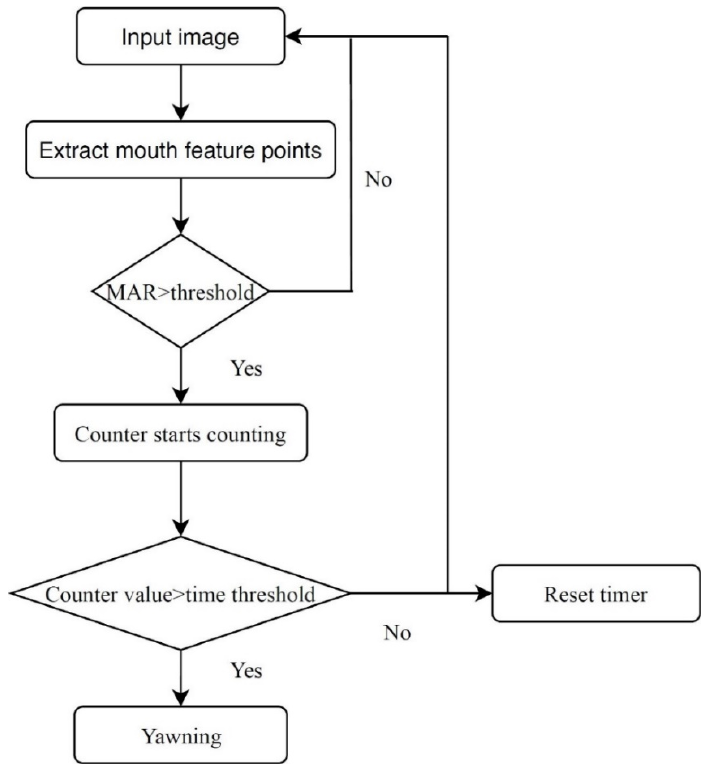
Figure 3. Flowchart for detecting yawns.